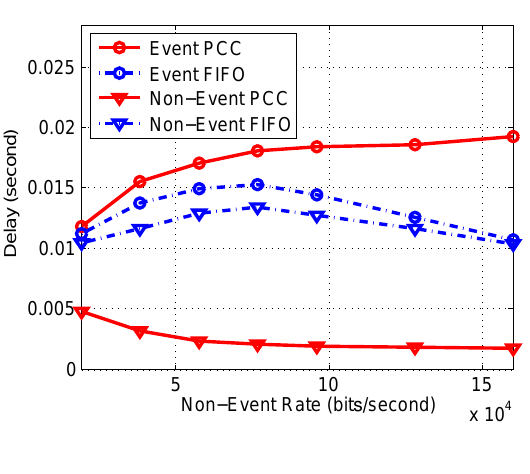
Figure 7. Avgerage end-to-end